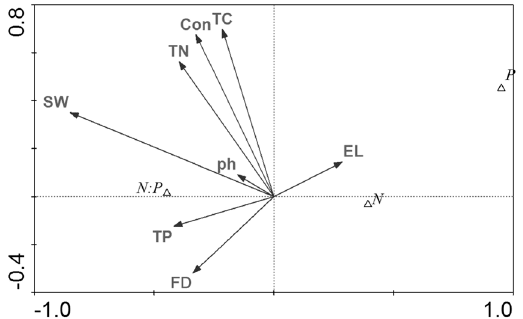
Figure 4. Canonical correspondence analysis (CCA) ordination for the foliar stoichiometric indexes and soil environmental characteristics of the 3 wetland species distributed along an elevation gradient in 3 lakeshore areas of Dongting Lake, China. N: foliar total nitrogen (N) concentration; P: foliar total phosphorus (P) concentration; N:P: ratio of foliar total N and total P concentrations; pH: soil pH; Con: soil conductivity;